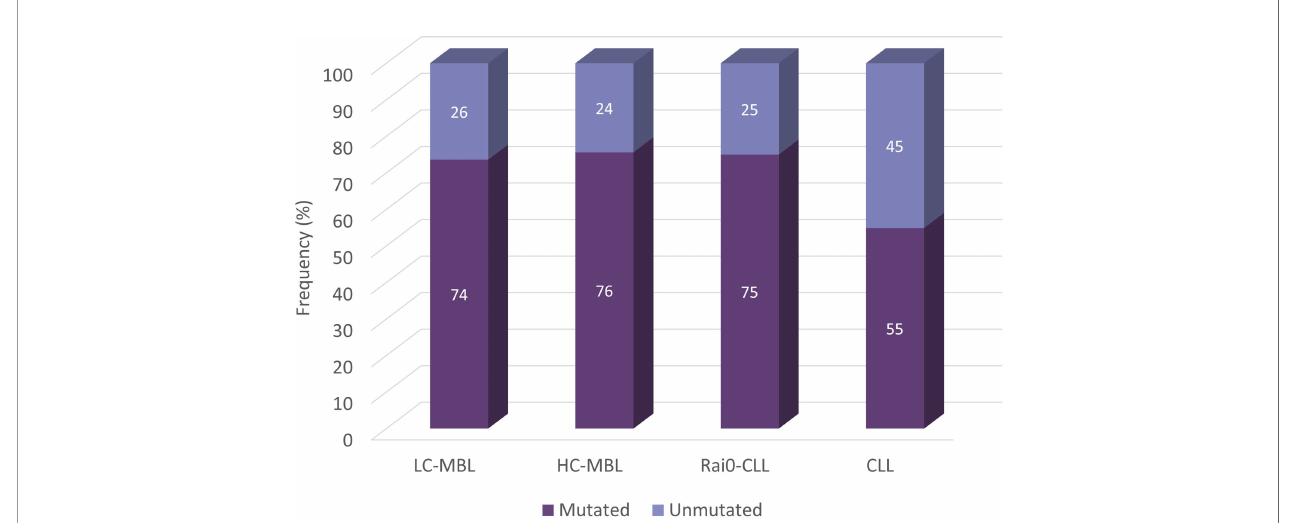
FIGURE 5 | Somatic hypermutation status in cohorts from LC-MBL, HC-MBL and CLL. Data was obtained from Vardi et al.